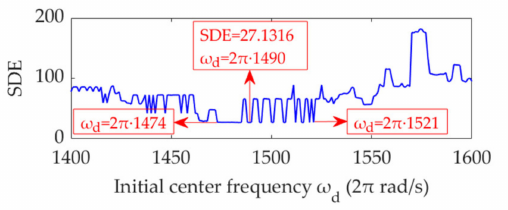
Figure 17. Relationship between the initial center frequency, ω d , and SDE